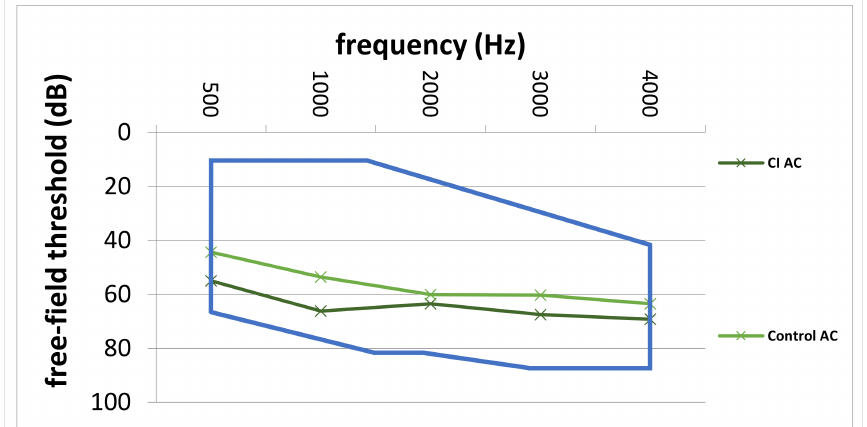
Figure 4. Average pre-VSB AC thresholds across frequencies for the CI and control group. The blue line represents the indication area for AC-thresholds (in the shown frequencies and sound levels) for VSB implantation for patients with SNHL. AC, air-conduction; Hz, Hertz; dB, Decibel; CI, cochlear implant; Control, control group; VSB, Vibrant Soundbridge; SNHL, sensorineural hearing loss.